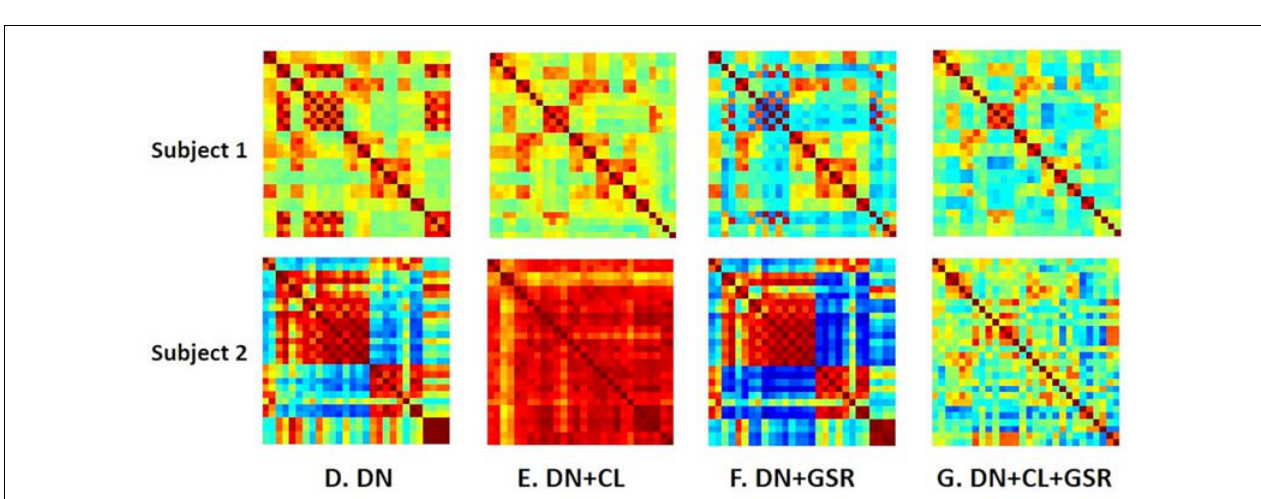
FIGURE 7 | Example FC matrices of two control rats scanned at 2 weeks (Subjects 1 and 2) processed with four different pipelines (D–G) . For Subject 1, GSR alone (pipeline F ) reinforces a widespread anti-correlation between the left and right hemispheres, manifest in a checkerboard pattern (odd/even rows and columns correspond to the left/right hemisphere ROIs, respectively) that was otherwise removed by ICA cleaning (pipeline E ). For Subject 2, GSR alone does not attenuate very strong positive/negative correlation blocks spanning large portions of the brain, whereas ICA cleaning alone yields artificially high whole-brain connectivity. The combination of CL + GSR (pipeline G ) mitigates these effects in both examples and yields more consistent between-subject connectivity